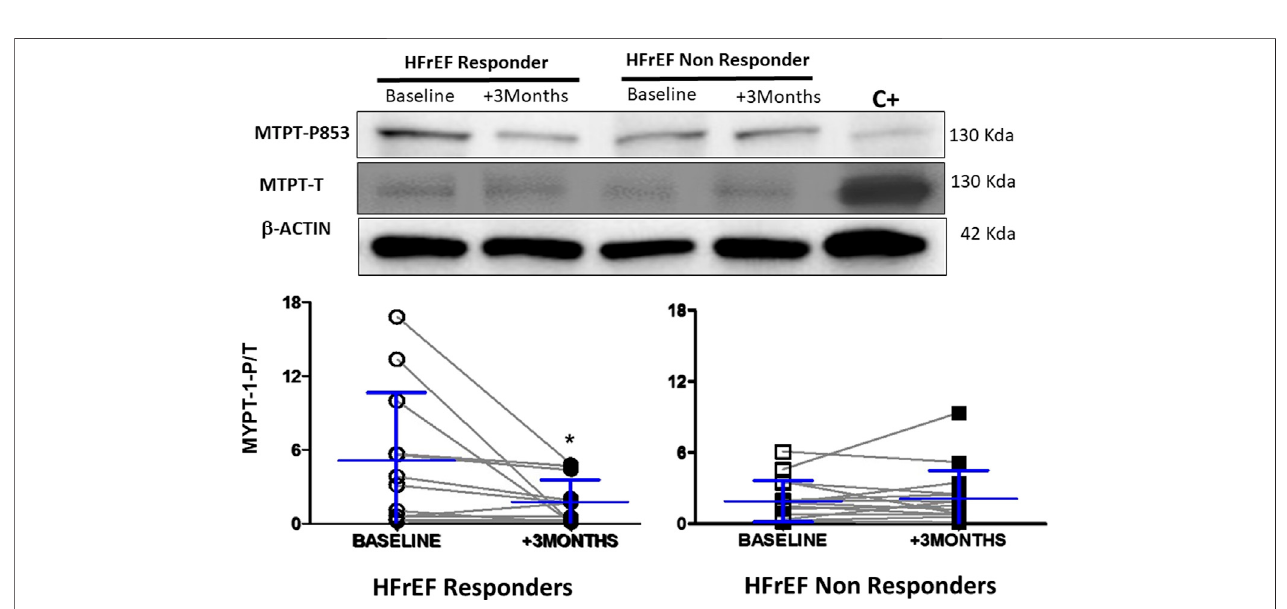
FIGURE 3 | ROCK activity in circulating leukocytes measured by MYPT-1 phosphorylation in responders ( n (cid:1) 13) and non responders HFrEF patients ( n (cid:1) 15) before and after cardiac resynchronization therapy. Upper panel: Representative Western blots from one responder and one non responder HFrEF patient before and after cardiac resynchronization therapy. Lower panel: MYPT-1-p/t in both groups. Data shown as mean ± SD. Symbols: ** (cid:1) p < 0.01 (non parametric Wilcoxon Signed Rank Test) vs baseline.